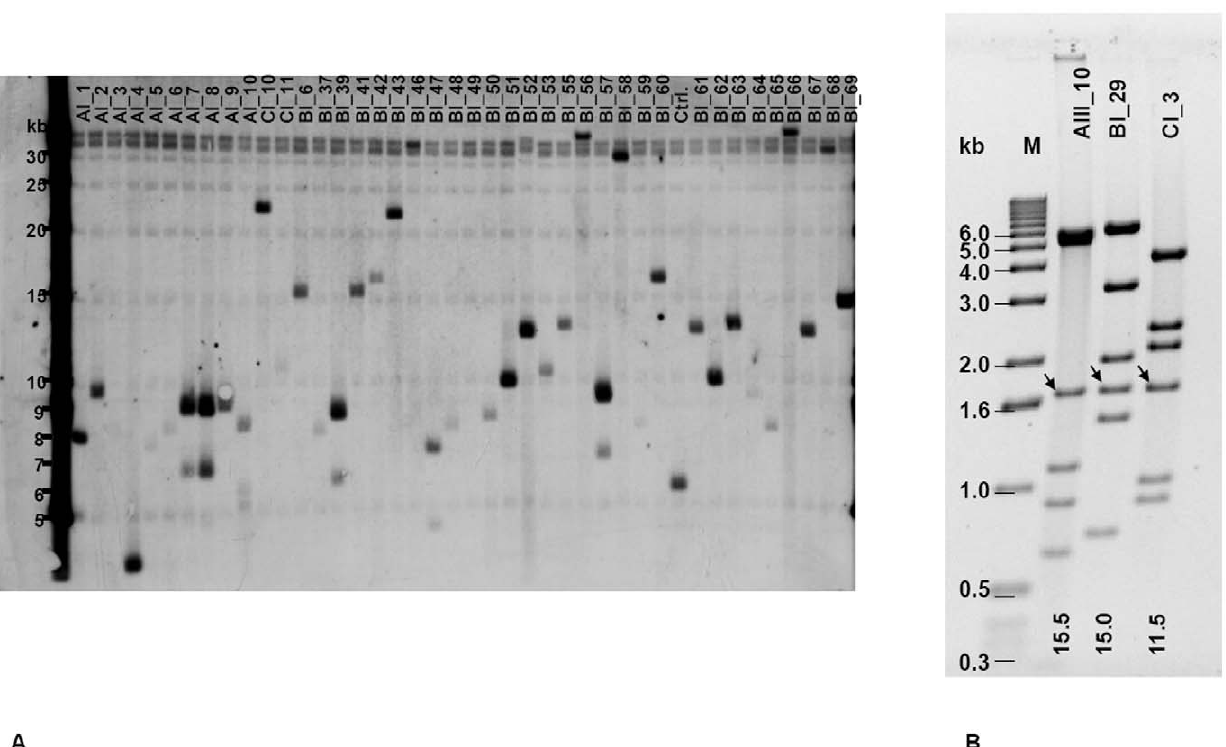
Figure 2. Southern blot analysis of var clones. (A) Southern blot example of 41 samples of NotI-digested genomic DNA of yeast TAR clones probed with vector-backbone. One lane contains a negative control (ctrl). (B) Restriction fragment pattern of TAR clones upsAIII_10, upsBI_29 and upsCI_3 digested with NotI and NdeI. The vector backbone yielded a band of 1600 bp and is marked with an arrow. The molecular marker is indicated. The upper band of the upsAIII_10 clones represents a double band.